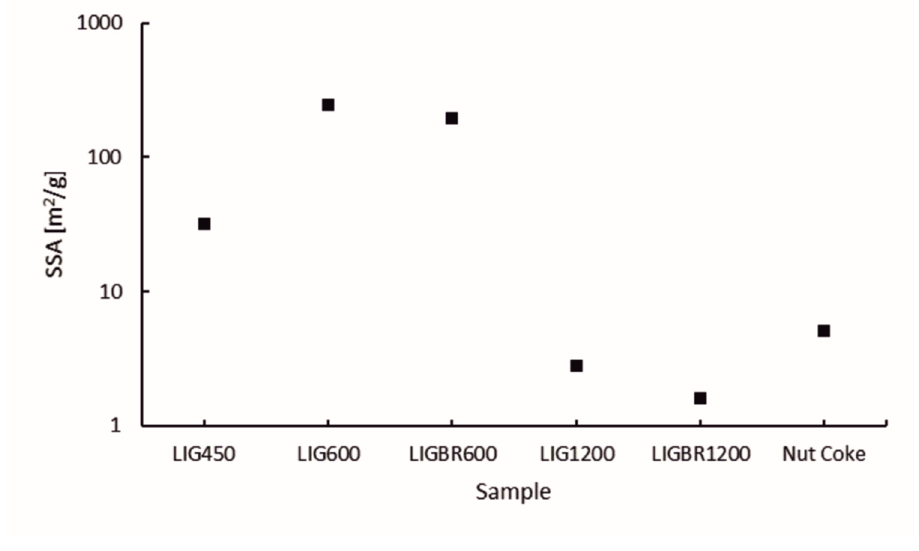
Figure 8. Specific surface areas of the samples.